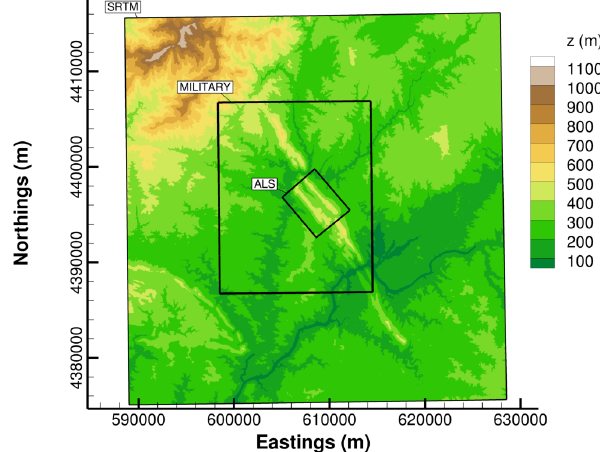
Figure 5. Total area comprised of SRTM, military and airborne data.